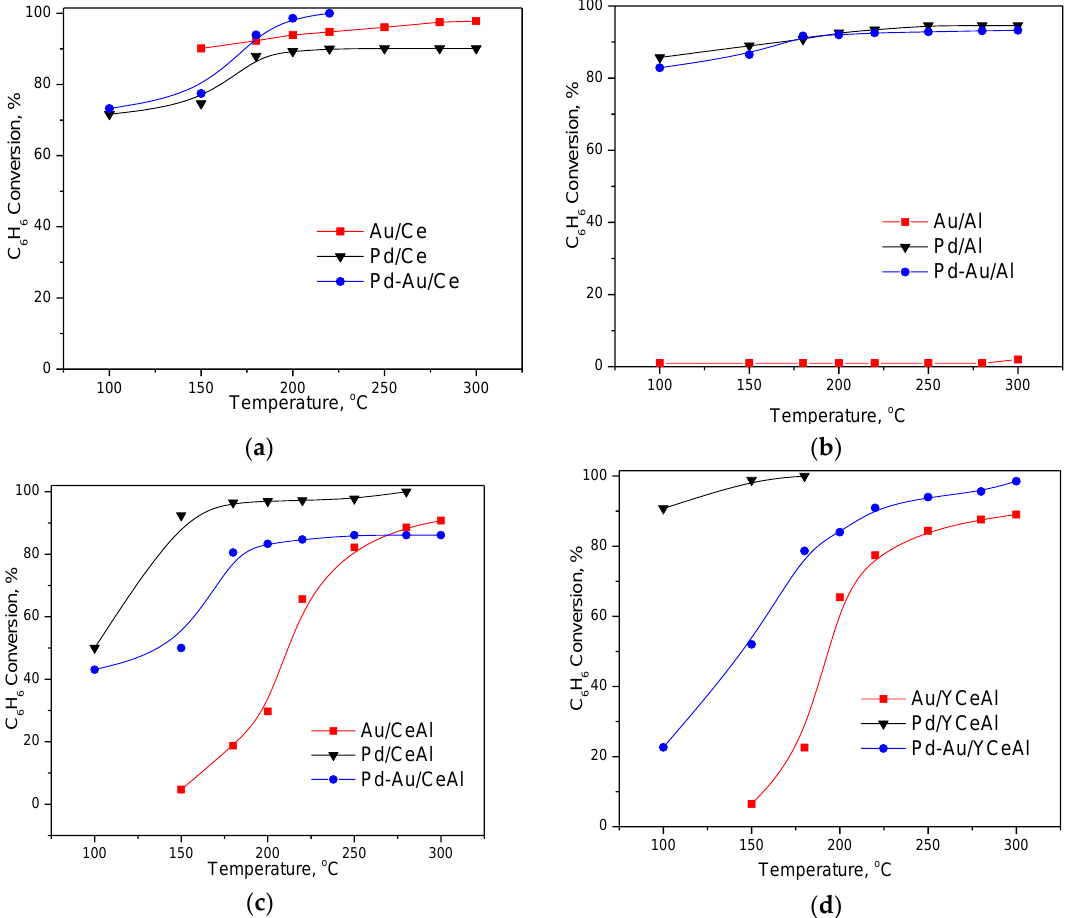
Figure 3. Temperature dependence of CBO of different formulations, depending on the support: ( a ) over CeO 2 ; ( b ) over Al 2 O 3 ; ( c ) over CeO 2 /Al 2 O 3 and ( d ) over Y-doped CeO 2 /Al 2 O 3 .